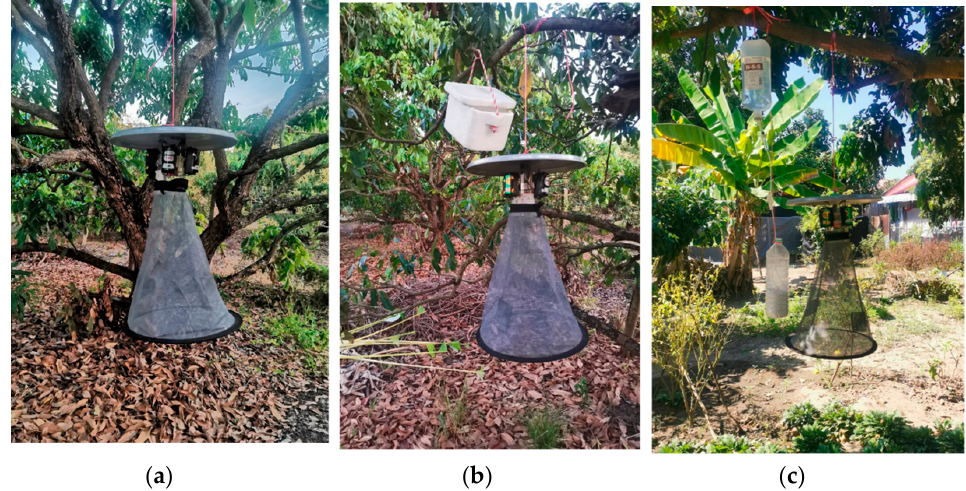
Figure 3. Three sets of traps in this study: ( a ) light trap (Set I); ( b ) light trap with dry ice (Set II); ( c ) light trap with CO 2 from limestone and acid reaction (Set III).